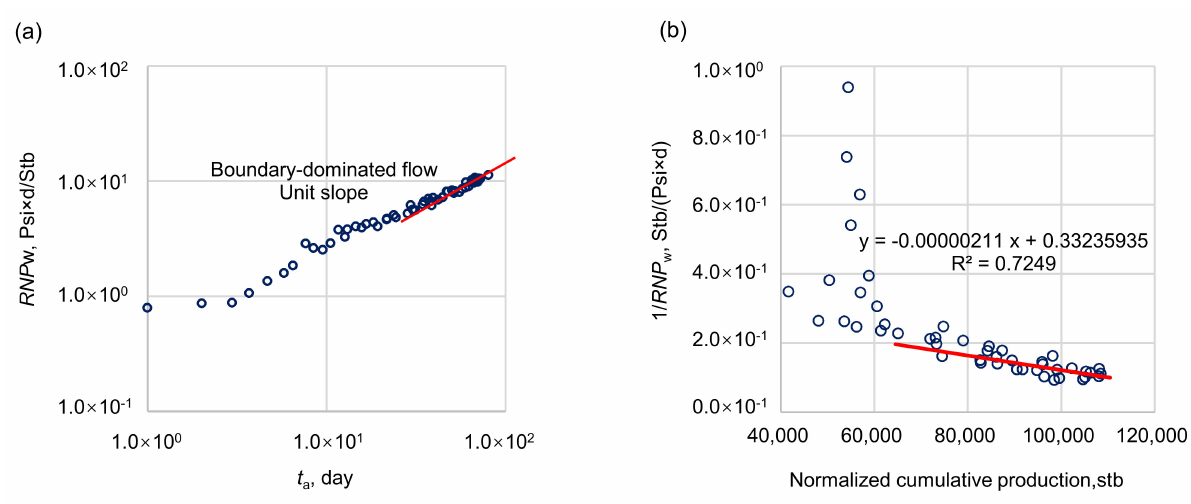
Figure 9. The single-phase (water) FMB of the field case: ( a ) the diagnostic plot of single-phase (water) and ( b ) the straight